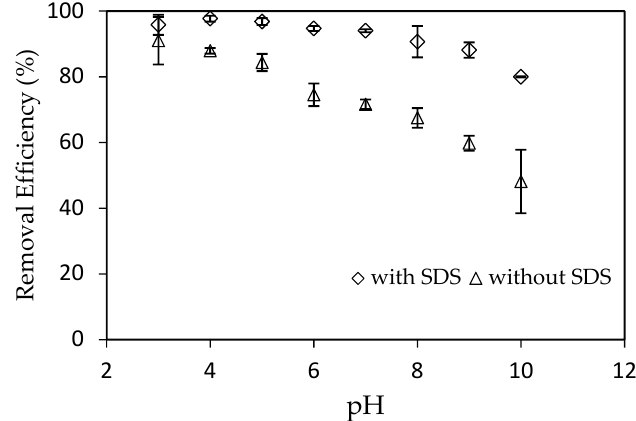
Figure 7. The effect of pH on RhB removal using synthesized nano γ -Al 2 O 3 without SDS modification (C i (RhB) = 10 − 6 M and with SDS modification (C i (RhB) = 10 − 4 M).